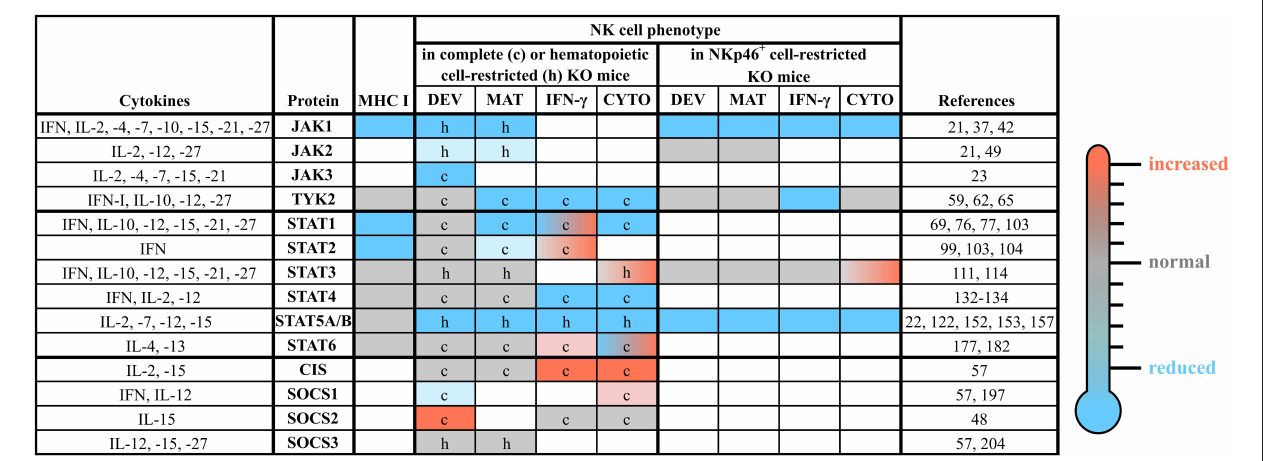
Frontiers in Immunology |